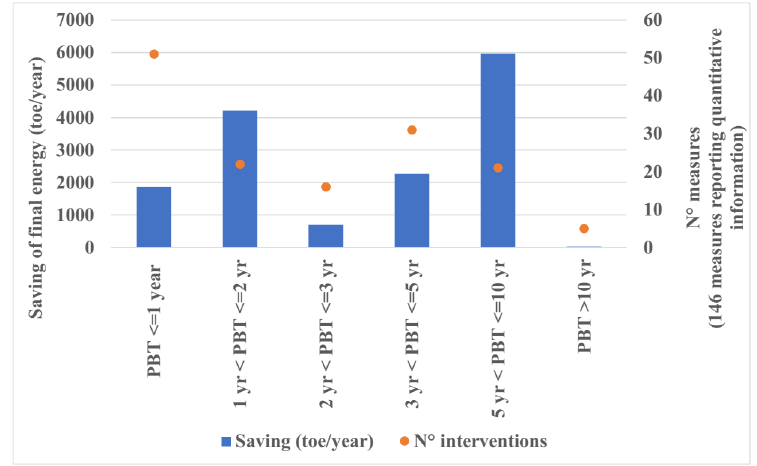
Figure 7. Annual savings and suggested interventions according to PBT